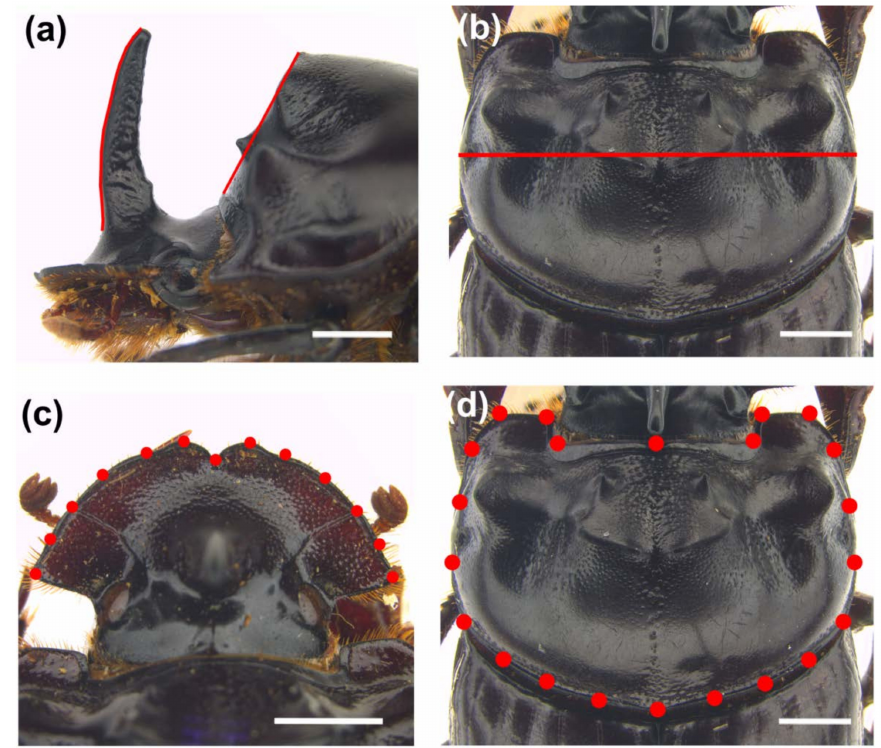
Figure 1. Copris lunaris . ( a ) Cephalic and pronotal horn length, and ( b ) maximum pronotum width measures; ( c ) head and ( d ) pronotum landmark configurations. Scalebars = 2